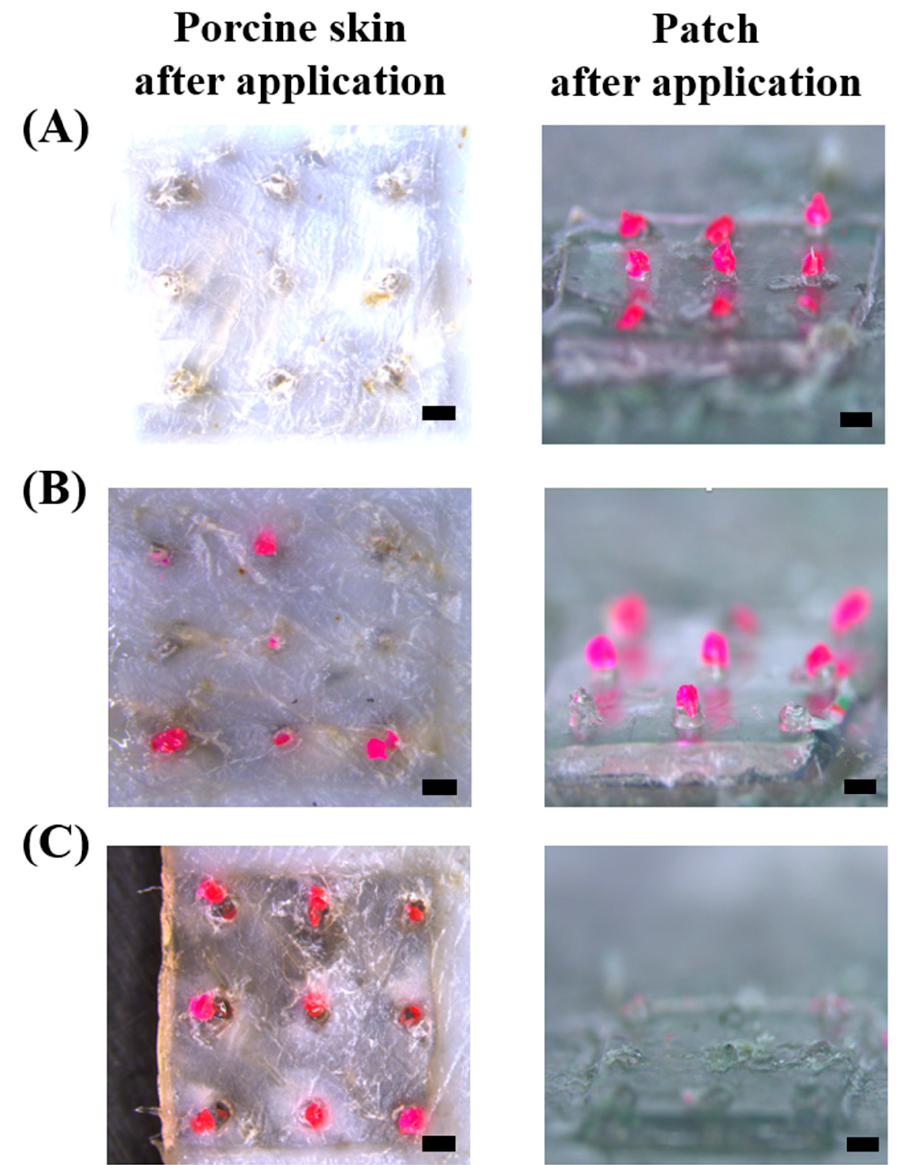
Figure 7. Separation of the PLGA part from the HMP-DMN patch at different application times. Microscopic images of porcine skin and HMP-DMN patches at different application times: ( A ) 0 min, ( B ) 5 min, and ( C ) 10 min after insertion. The left column shows porcine skin after application, and the right column shows HMP-DMN residuals on the patch after application. After application for 10 min, the PLGA mixture from the HMP-DMN patch was found to have been completely implanted into the skin. Scale bar: 500 µ m. (PLGA: poly(lactic-co-glycolic acid), HMP-DMN: heat-melt PLGA dissolving microneedle).